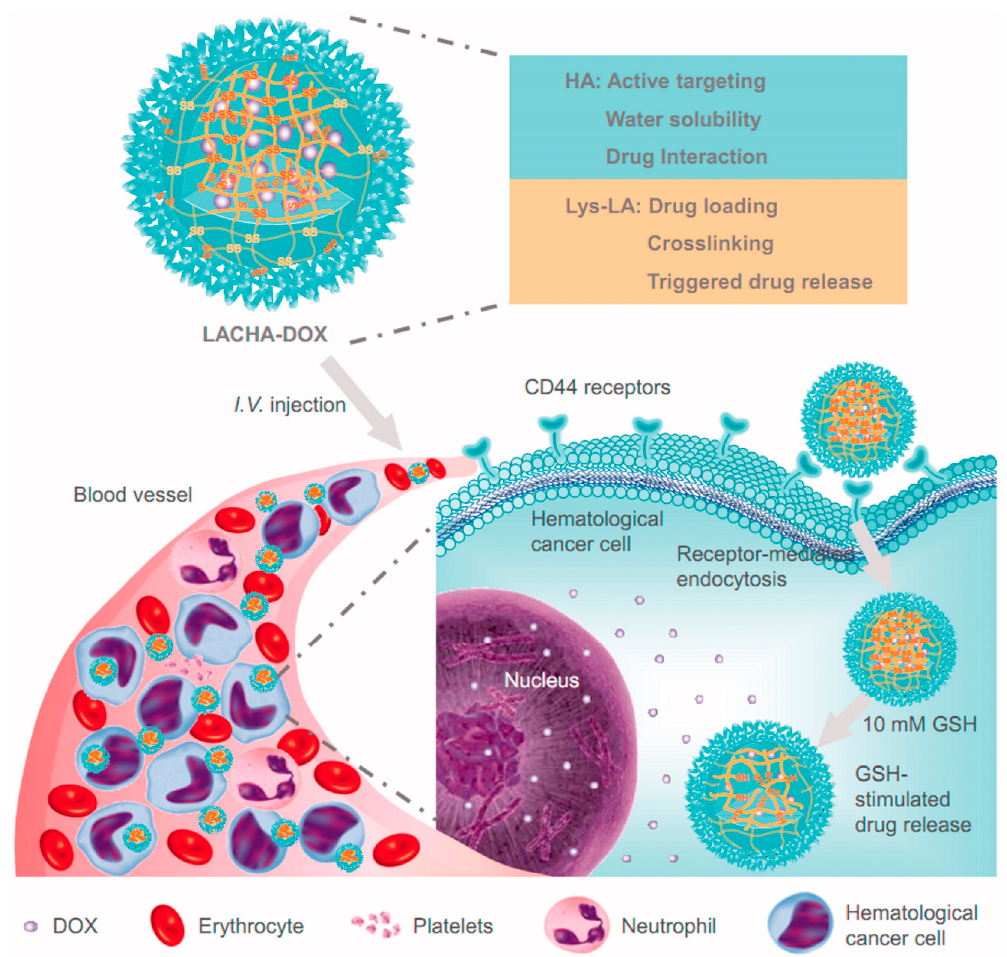
Figure 2. Doxorubicin (DOX)-encapsulated lipoic acid-crosslinked hyaluronic acid nanoparticles (LACHA) for the treatment of CD44 over-expressed hematologic malignancy. Reproduced from Ref. [37].